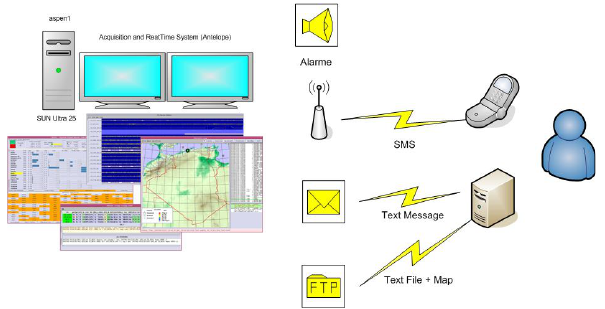
Fig. 6. Transmission of the alert messages from the Seismic Net- work Center to the users.